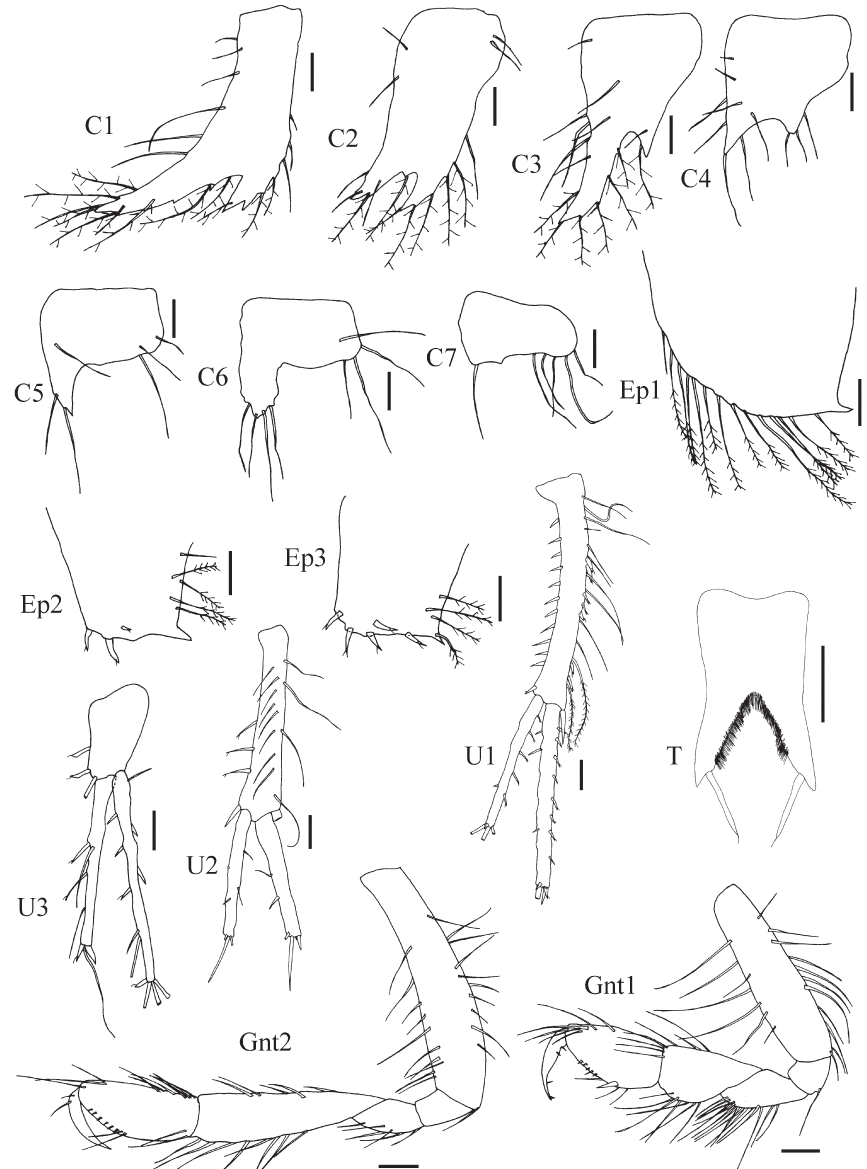
Fig . 6. – Lepechinella hirsuta n. sp., holotype, female, 5.5 mm, MnrJ20523, oceanprof i #60, 21°52’50.5’’S to 39°51’42.6’’w. Scale bars: = 0.1